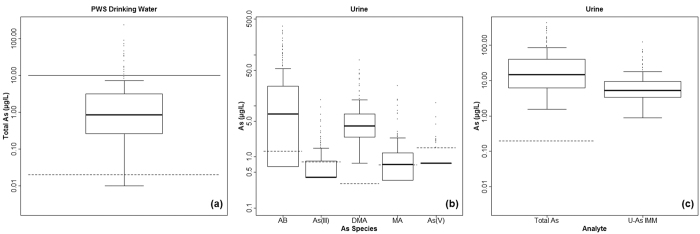
Box and whisker plots of private water supply (PWS) drinking water and urinary As.(a) Total As in drinking water samples plotted with its analytical limit of detection (LOD) (lower dashed line) and the UK As PCV (upper solid line). (b) Individual urinary As species plotted with their respective LODs (dashed lines). (c) Urinary total As and urinary sum of species excluding AB (U-AsIMM). Boxes range from 1st to 3rd quartiles with a median line, lower and upper whiskers are the lowest and highest datum within 1.5 inter quartile range (IQR) of the lowest and upper quartile respectively and circles are outliers. For plotting purposes, speciation data were censored by replacing <LOD values with ½ LOD.